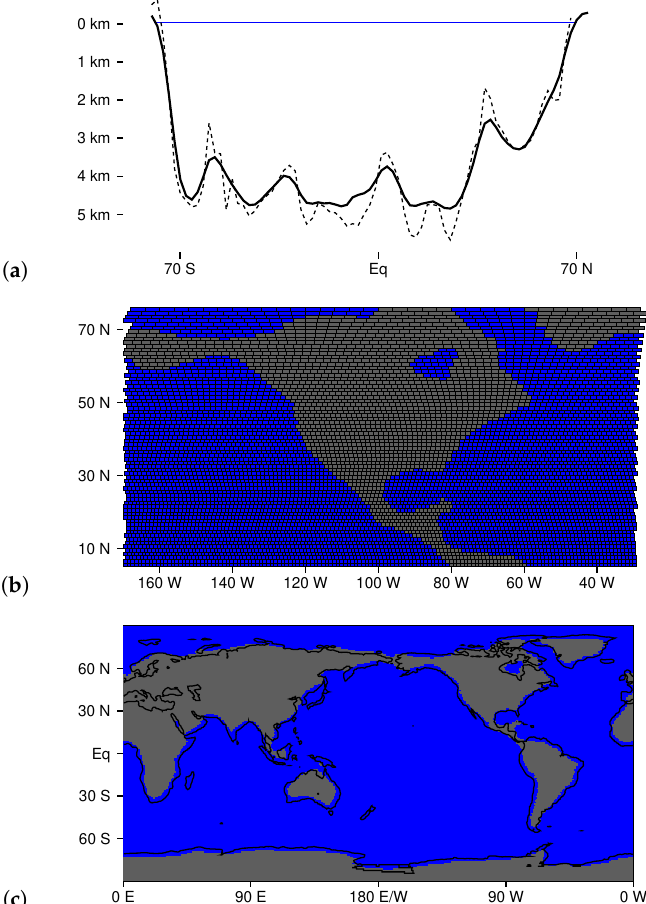
Figure 3. Bottom topography and spherical geometry. ( a ) Model bottom surface along 30 W (solid black line), the observed bathymetry (dashed line), and the undisturbed free surface height (blue). ( b ) Spherical geometry for North America. Each grid box used for calculating the pressure force is outlined in black. ( c ) Regions of land (gray) and ocean (blue) as determined by the zero height contour. The solid black line denotes the actual position of the land–sea